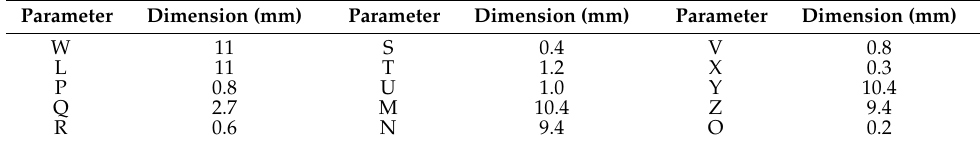
Figure 1. Different views of the unit cell: ( a ) Top view, ( b ) Isometric view.